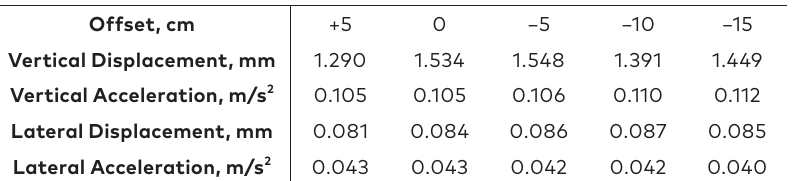
Table 5. Peak dynamic response at bridge